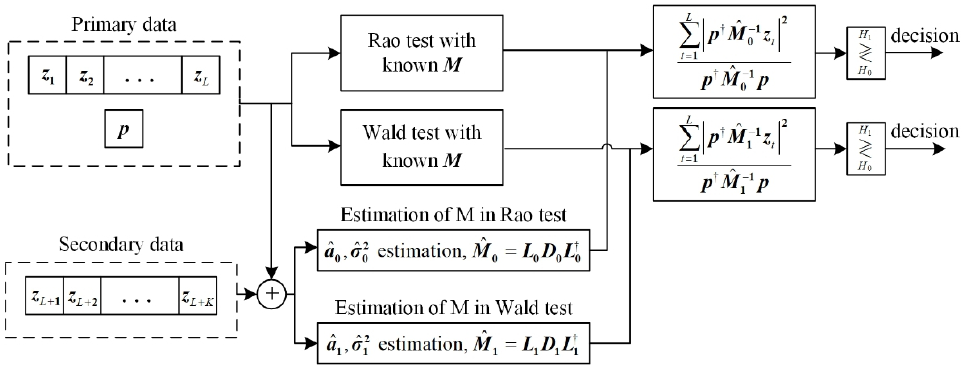
Figure 1. Block diagram of the detectors design